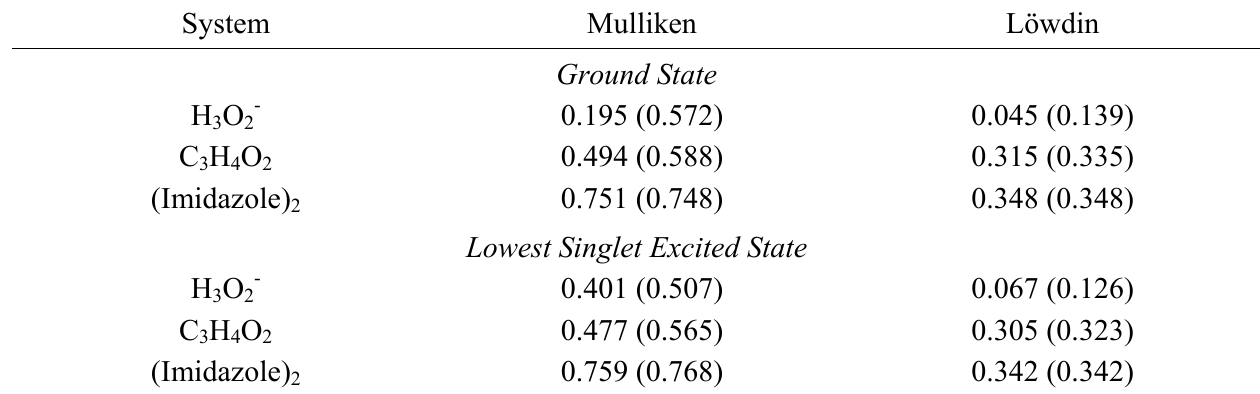
Table 5 . Mulliken and L ő wdin hydrogen bond proton charges in model systems within the 6-31G** basis set for ground and lowest singlet excited state. In parentheses the respective values for the middle hydrogen bond proton position are